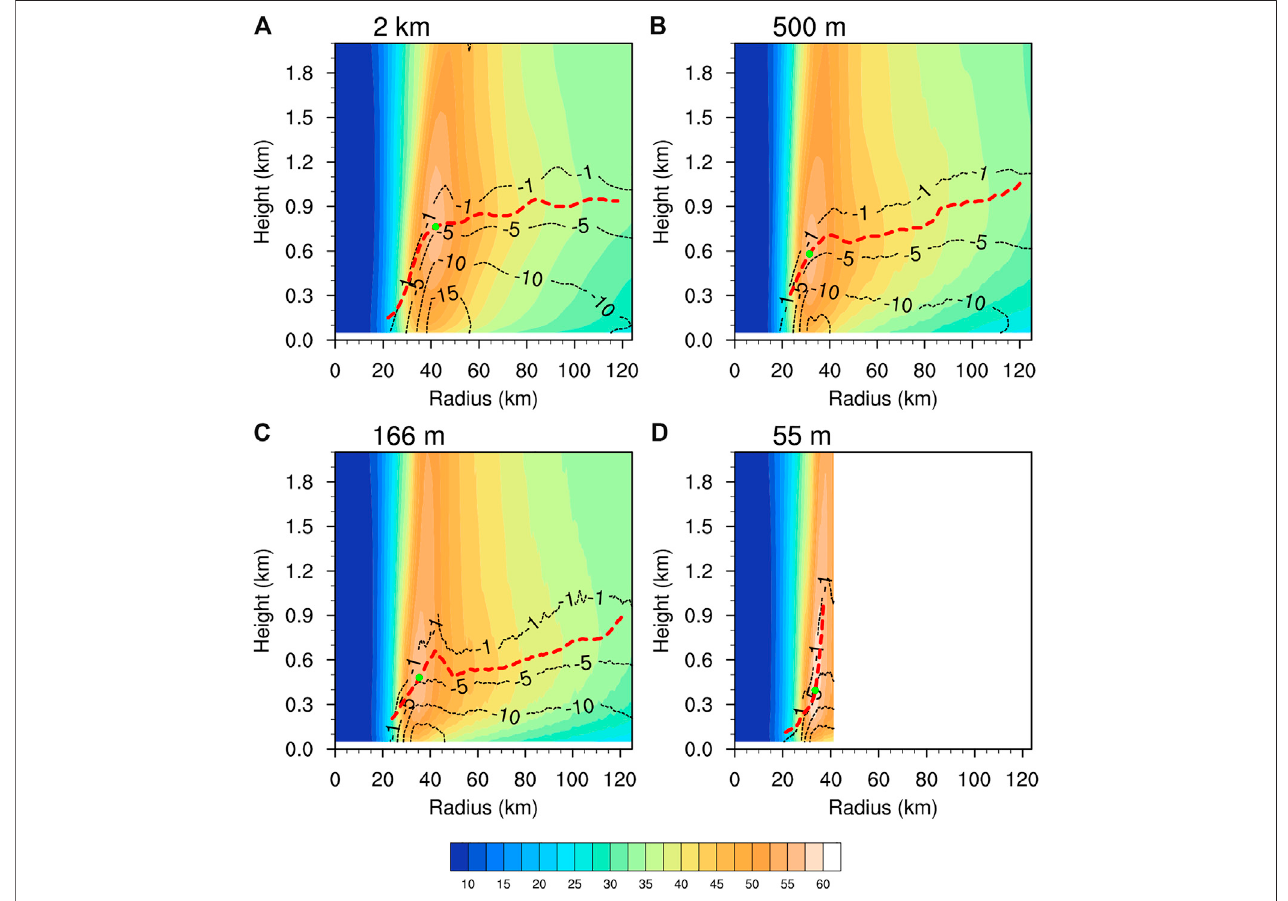
FIGURE4| Azimuthmeantangential(shaded,m s − 1 )andradial(contour,m s − 1 )windsatt (cid:2) 9 hofthesimulationfromthegridspacingsof (A) 2 km, (B) 500 m, (C) 166 m, and (D) 55 m, respectively. The red lines indicate the heights of the maximum tangential wind varying with radius. The green dot represents the location of the maximum tangential wind.